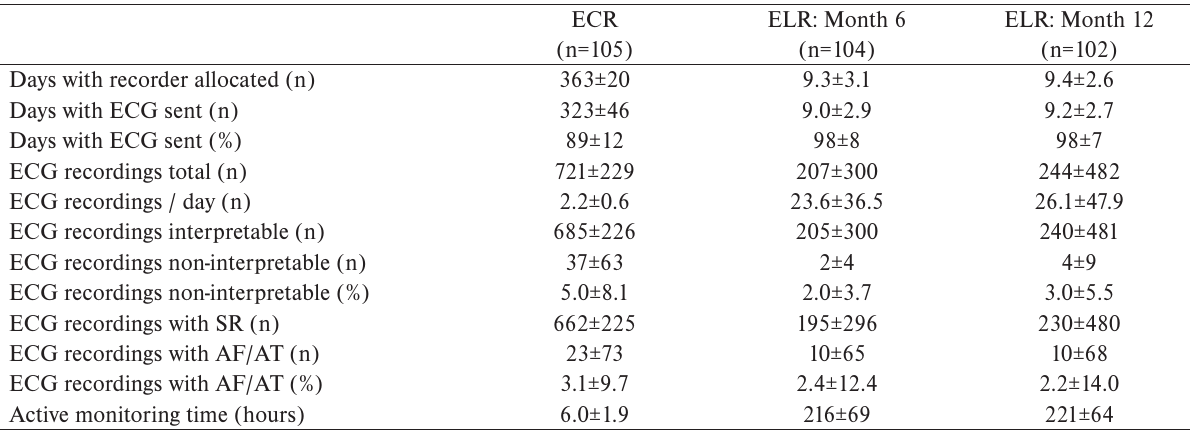
recorder, SR = sinus rhythm.